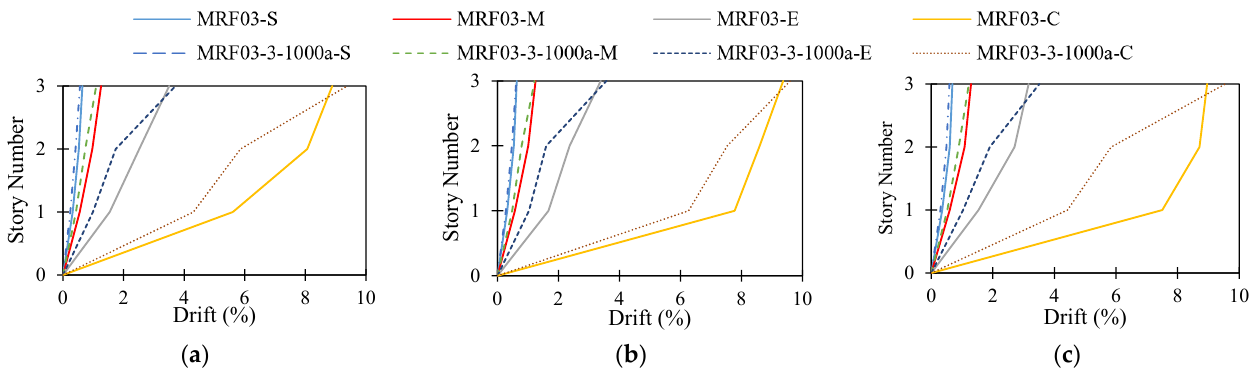
Figure 12. Inter-story drift ratios for 3-story structure subjected to ( a ) FF, ( b ) NF-No Pulse, and ( c ) NF-Pulse records, respectively.